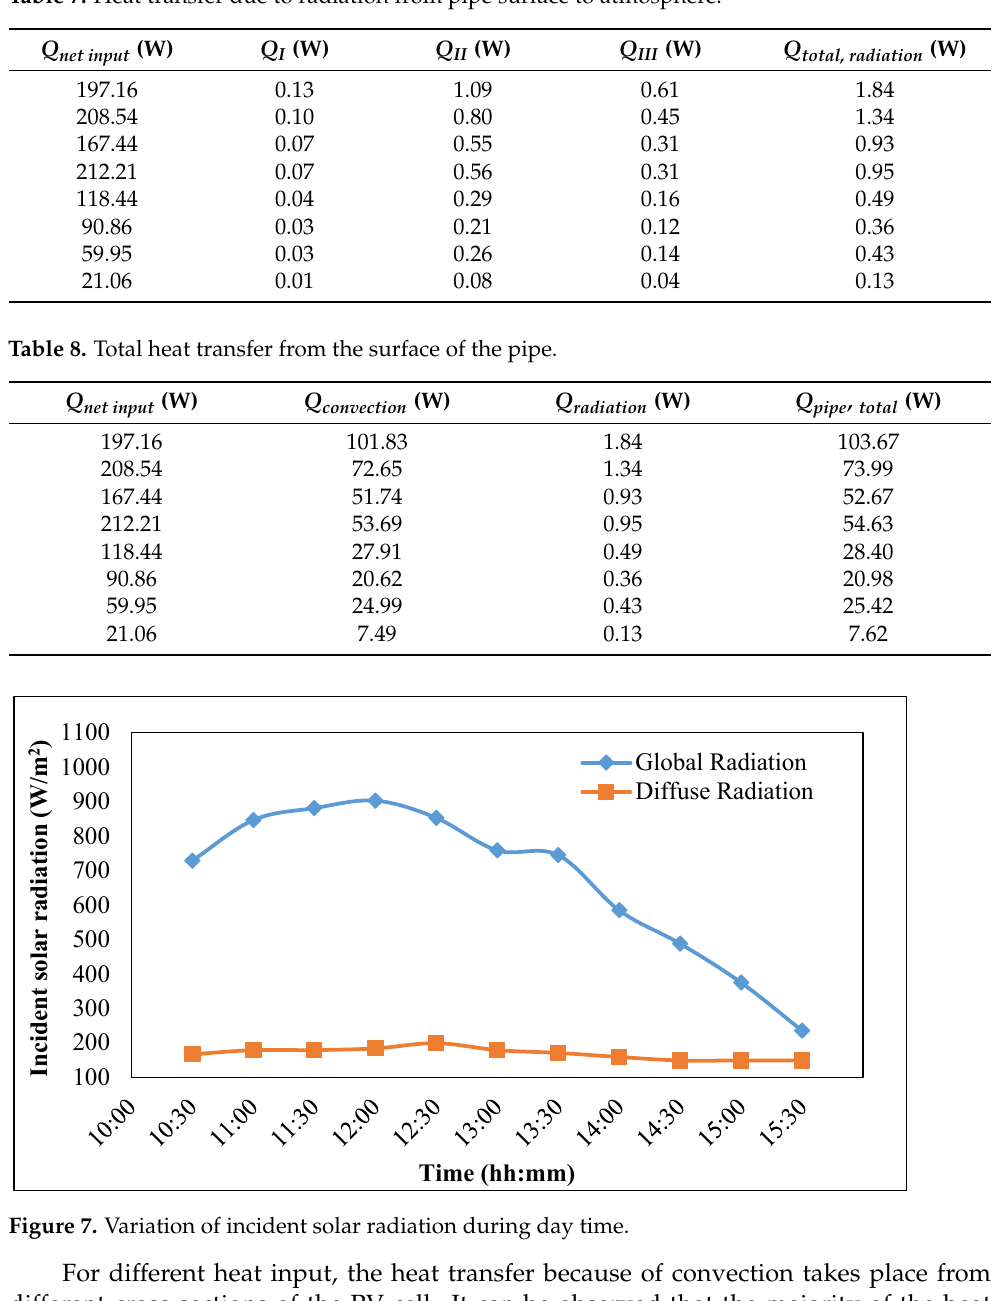
Table 7. Heat transfer due to radiation from pipe surface to atmosphere.